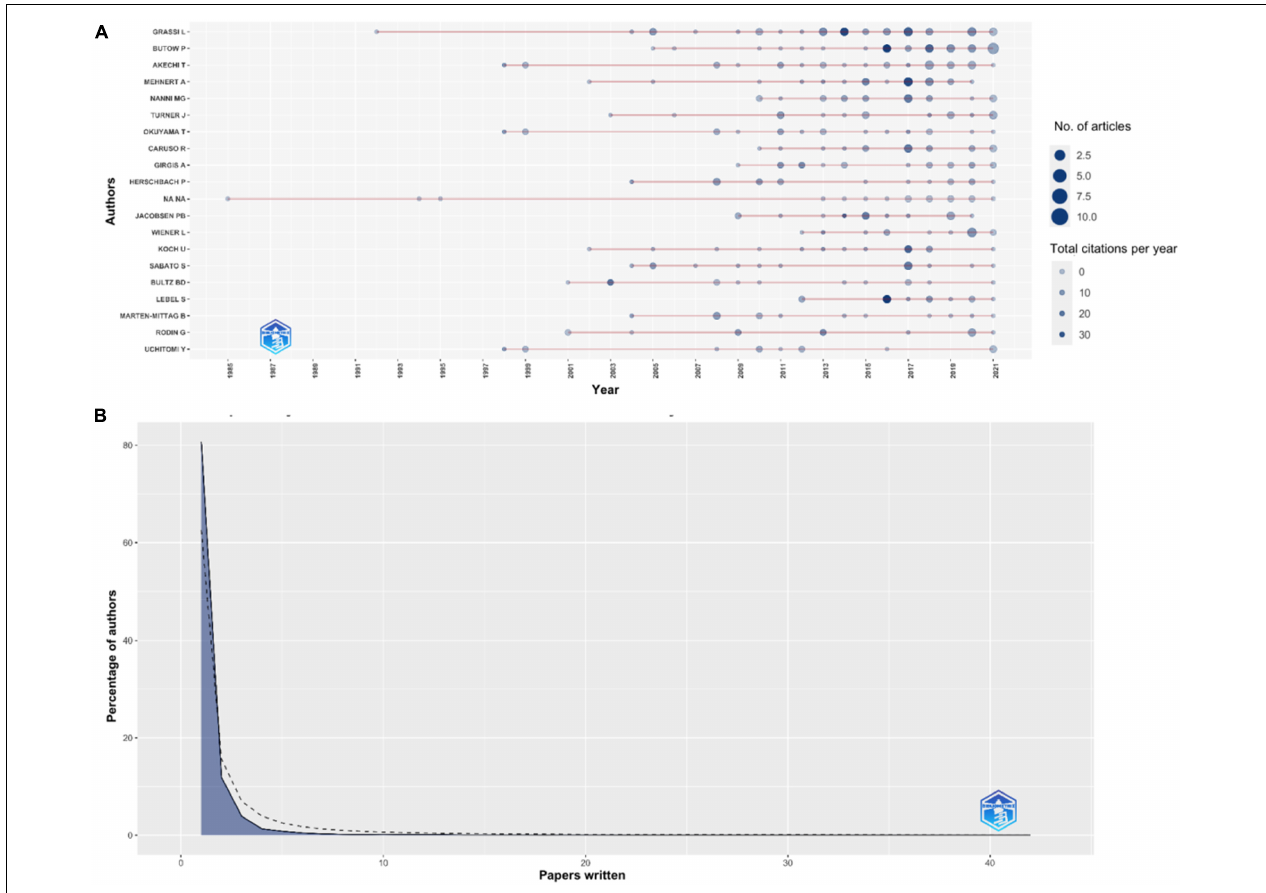
FIGURE 2 | (A) Top authors’ production over time (1985–2021) in psycho-oncology research, (B) author productivity through Lotka’s law. The blue area corresponds to the empirical or observed data, whereas the dotted line represents plotted or theoretical relationship.